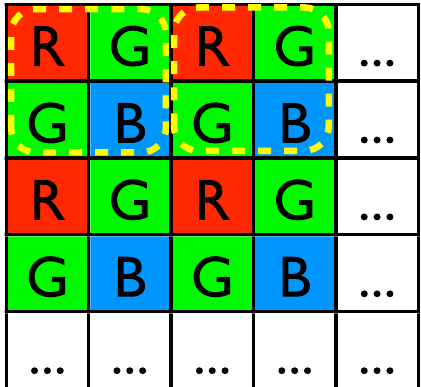
Fig. 2. Distribution of red, green and blue elements in the Bayer colour filter array. The yellow dashed lines circle the four-pixel groups that are used as grid points in the interpolation (colour syn-